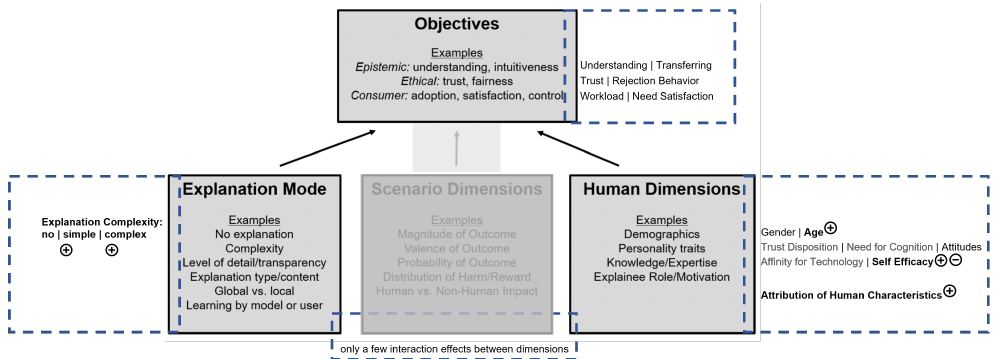
Figure 1. The figure shows the framework of explanation dimensions adopted from Lu et al. (2019). Shown in gray are the original dimensions and objectives. Grayed out are the aspects (scenario dimensions) that were not included in this study. The blue dotted frames contain the assessed indicators. The stronger the font color, the more influence the indicators had on the objectives. A plus stands for an enabling influence and a minus for an inhibiting